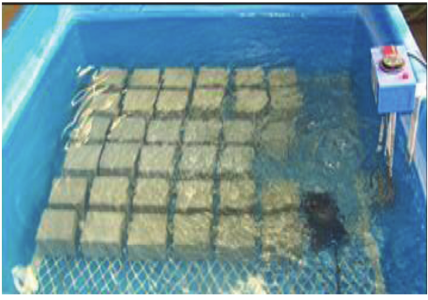
Figure 2: Water curing (WAC).